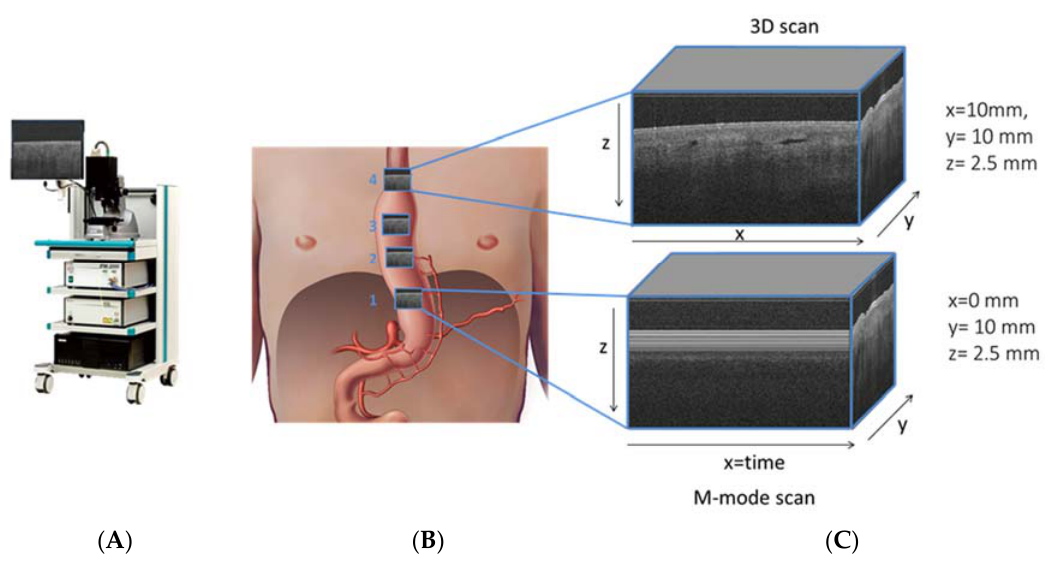
Figure 2. Santec OCT system (panel A ), schematic figure (panel B ) of gastric tube with ROI of 10 × 10 mm of OCT grayscale images at four perfusion areas, with shadowing of vessels in cross sectional OCT image (panel C ).